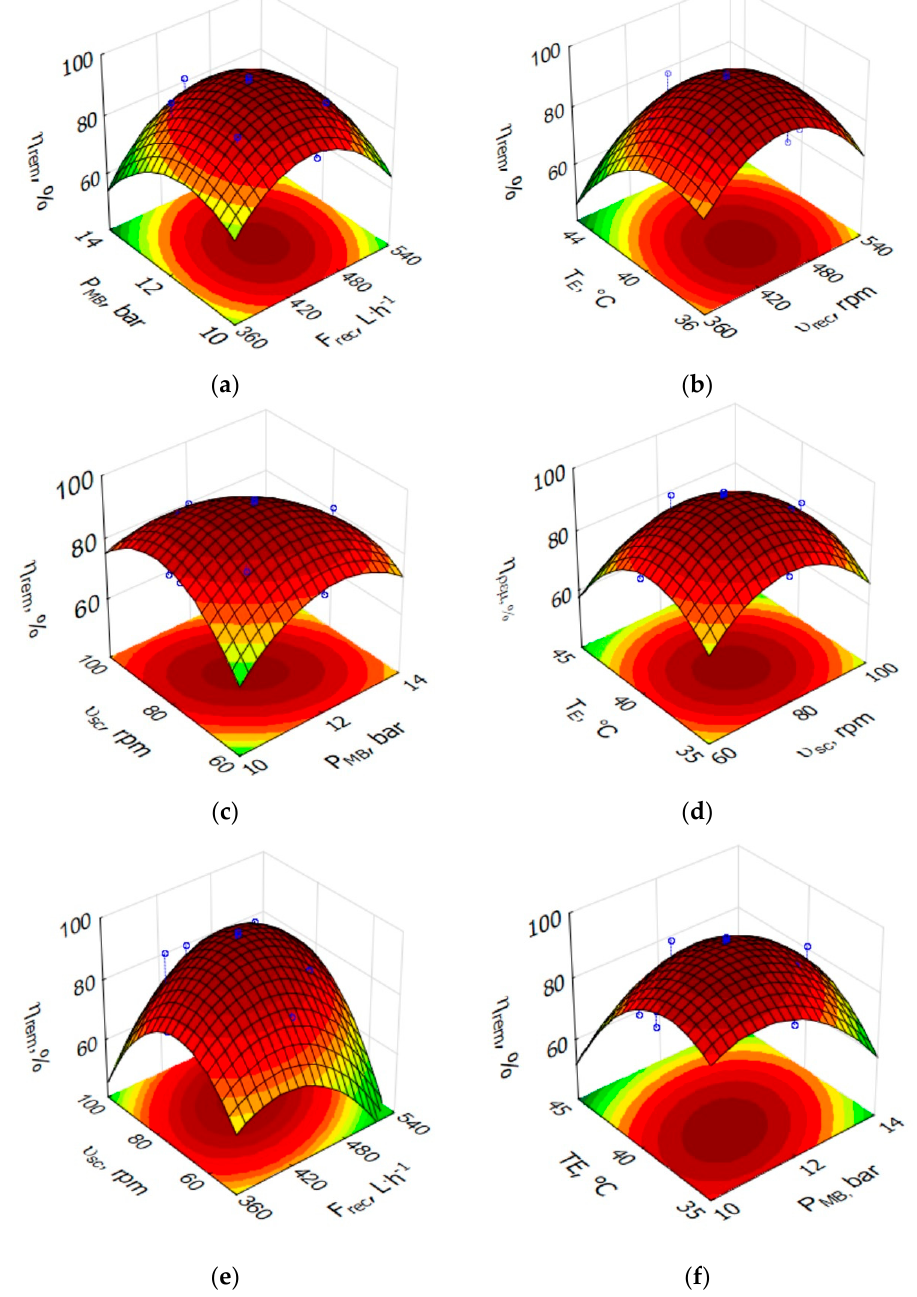
Figure 5. Response surfaces for oil and grease removal efficiency ( η rem , %) as function of: ( a ) Recycle flow rate (F rec , L · h − 1 ) and Microbubbles pump pressure (P MB , bar); ( b ) Recycle flow rate (RFR, RFR, L · h − 1 ) and Feed effluent temperature (FET, ◦ C); ( c ) Microbubbles pump pressure (MPP, bar) and Scraper rotation speed (SRS, rpm); ( d ) Feed effluent temperature (FET, ◦ C) and Microbubbles pump pressure (MPP, bar); ( e ) Recycle flow rate (L · h − 1 ) and scraper rotation speed (rpm); ( f ) Scraper rotation speed (rpm) and Feed effluent temperature (FET, ◦